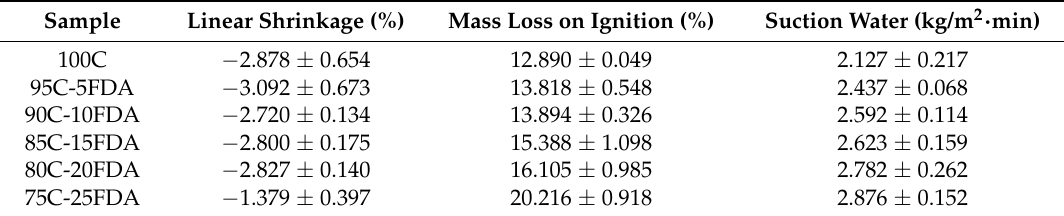
Table 3. Technological properties of fired bricks made from clay and AFD